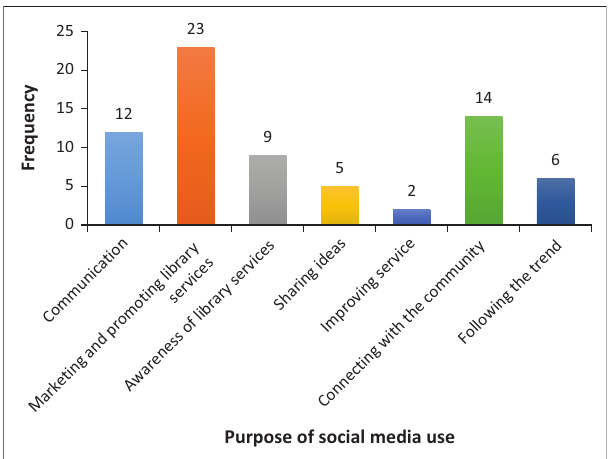
FIGURE 2: Public libraries’ use of social media ( N =